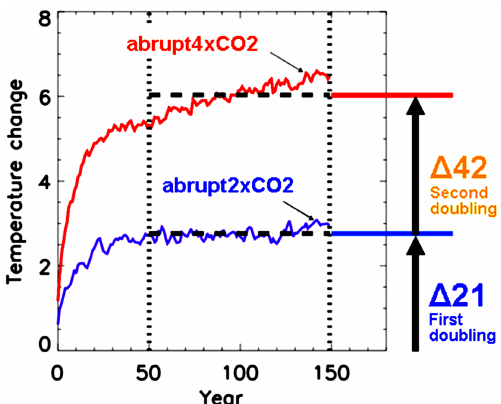
Figure 3. Defining the “doubling difference”. The red and blue lines show illustrative time series of a variable (in this example, global- mean temperature from HadGEM2-ES) from the abrupt4xCO2 and abrupt2xCO2 experiments. Doubling difference = (cid:49) 42– (cid:49) 21 (the difference in response between the first and second CO 2 doublings). This is defined for a specific timescale after the abrupt CO 2 change – in this example, it is for means over years